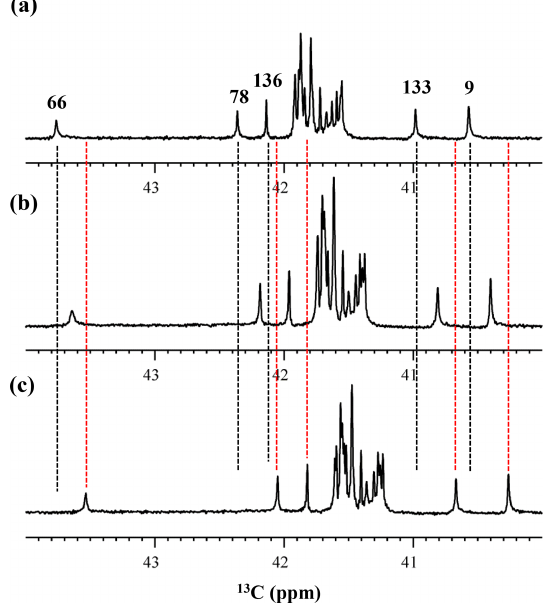
Figure 5. Isotope shifts on the 13 C ε signals of the Lys residues in the SNase variant selectively labeled with [ ε - 13 C; ε , ε -D 2 ]-Lys, caused by the deuterium substitutions for the ζ -amino groups. The 125.7MHz { 1 H, 2 D}-decoupled 1D 13 C NMR spectra were mea- sured at 25 ◦ C, pH 8.0, in either H 2 O (a) , H 2 O:D 2 O (1:1) (b) , or D 2 O (c) solutions on an Avance 500 spectrometer equipped with a DCH cryogenic probe in H 2 O (a) , H 2 O:D 2 O (1:1) (b) , and D 2 O (c) solutions. The vertical dotted black and red lines show the chemical shifts observed in 100% H 2 O and D 2 O, respectively. The complete data for the deuterium-induced isotope shifts for the side- chain 15 N ζ and 13 C ε signals are summarized in Table